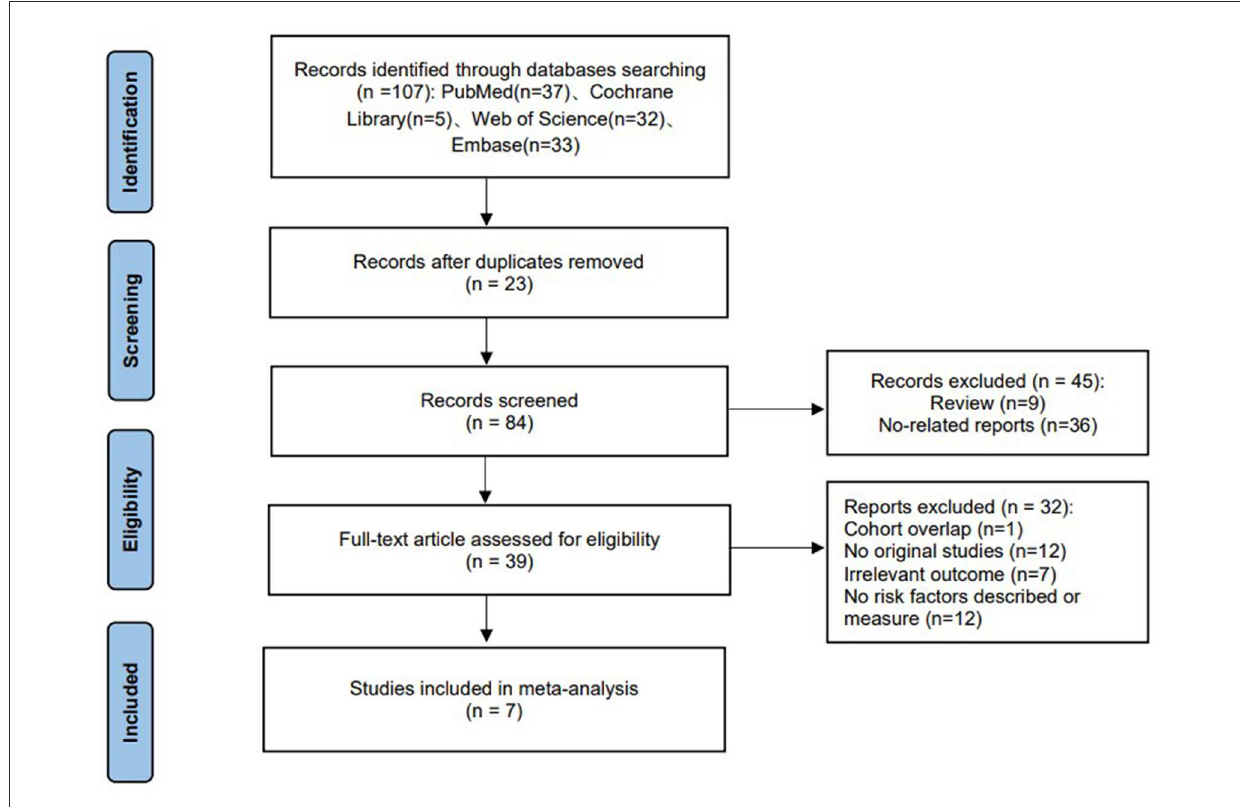
FIGURE1 Study flow